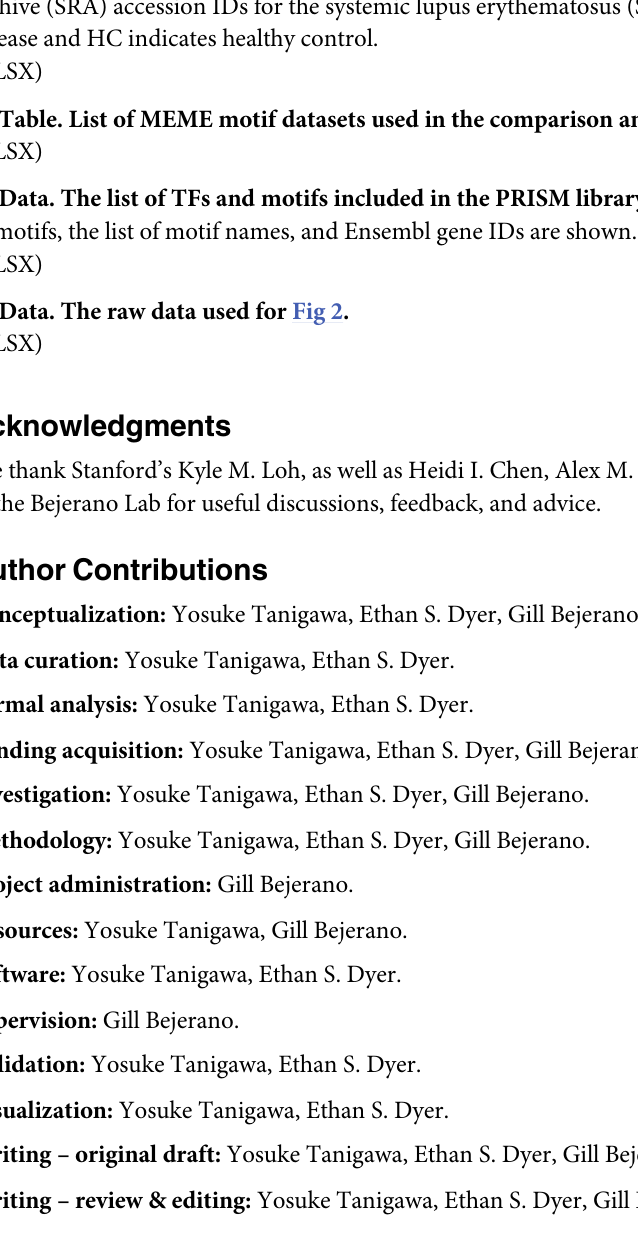
S7 Table. The update summary of GREAT v4.0.4 ontologies. Ensembl genes is a flat ontol- ogy defined from the set of genes with at least one meaningful annotation in gene ontology (Methods). S8 Table. Accession IDs used in the analysis. (a) Human ENCODE accession IDs (EID) used in our study and the corresponding cell type or tissue. (b) Mouse ENCODE accession IDs used in our study and the corresponding cell type or tissue. (c) Mesoderm development sample IDs, sample description, and the reference to the corresponding results. (d) Sequence read archive (SRA) accession IDs for the systemic lupus erythematosus (SLE) dataset. SLE indicates disease and HC indicates healthy control. S9 Table. List of MEME motif datasets used in the comparison analysis. (XLSX) S1 Data. The list of TFs and motifs included in the PRISM library. The TF names, number of motifs, the list of motif names, and Ensembl gene IDs are shown. (XLSX) S2 Data. The raw data used for Fig 2.